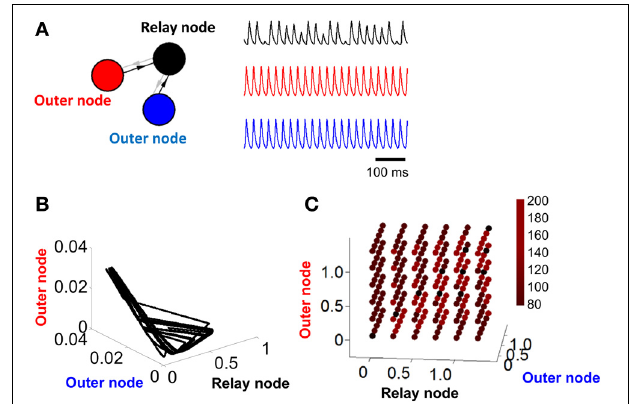
FIGURE 2 | Activity becomes unstable in a relay network with no feedback connections. (A) Left: illustration of a three-node network where connections are strictly feedforward (connections in gray are set to zero, i.e., α = 0 in Equation 1). Right: pattern of activity obtained for each of the three nodes in (A) over time. (B) Phase-plane of activity where nodes in (A) are simulated with a Wilson–Cowan model. (C) Duration (in ms) of stable cycles in a relay network with both feedback and feedforward connections between nodes. Each dot shows initial conditions for the relay node and the two outer